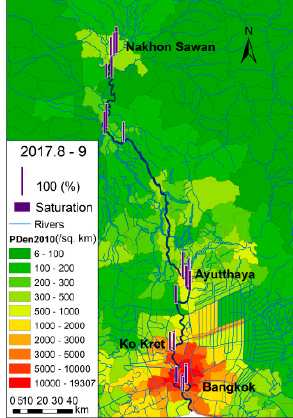
Figure 3. DO Figure 3. DO saturation. Figure 3. DO saturation.